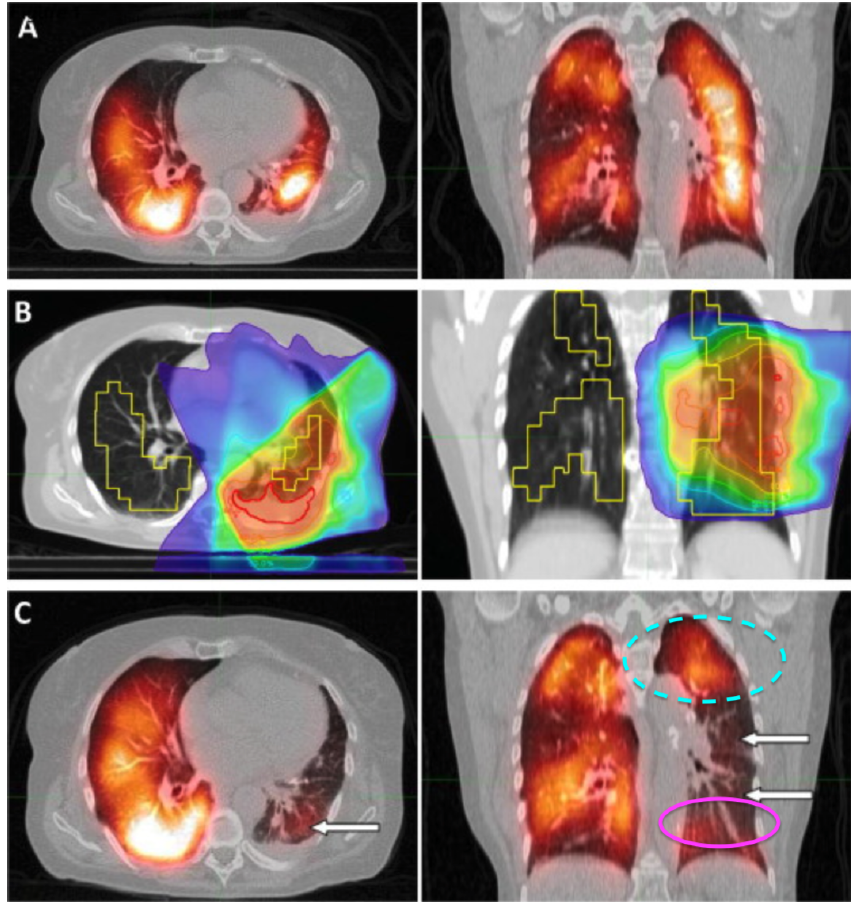
Figure 7. Taken from Farr et al. [25]. SPECT/CT of a patient with tumor in the right lung before radiotherapy ( A ), planning CT with dose to the gross tumor volume in color wash, SPECT defined functional lung outlined in yellow ( B ), SPECT/CT 3-months post-RT ( C ). A dotted cyan oval is drawn to indicate a region that received low dose but did not experience perfusion decline. A magenta oval is drawn in another region that received low dose but did experience perfusion decline post-RT and is fed by an irradiated region. Reprinted with